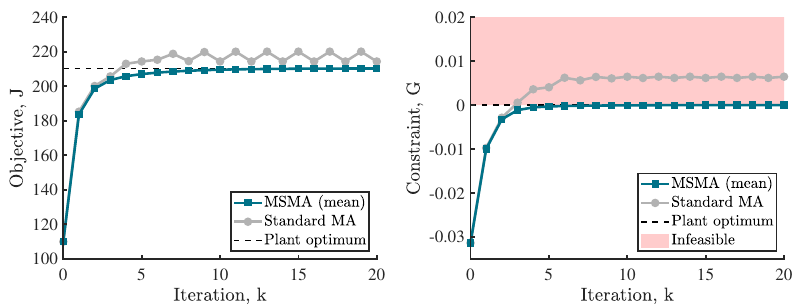
Figure 6. WO case study using the mean solution selection method and regional quadratics, compared to standard MA using the same input filter.